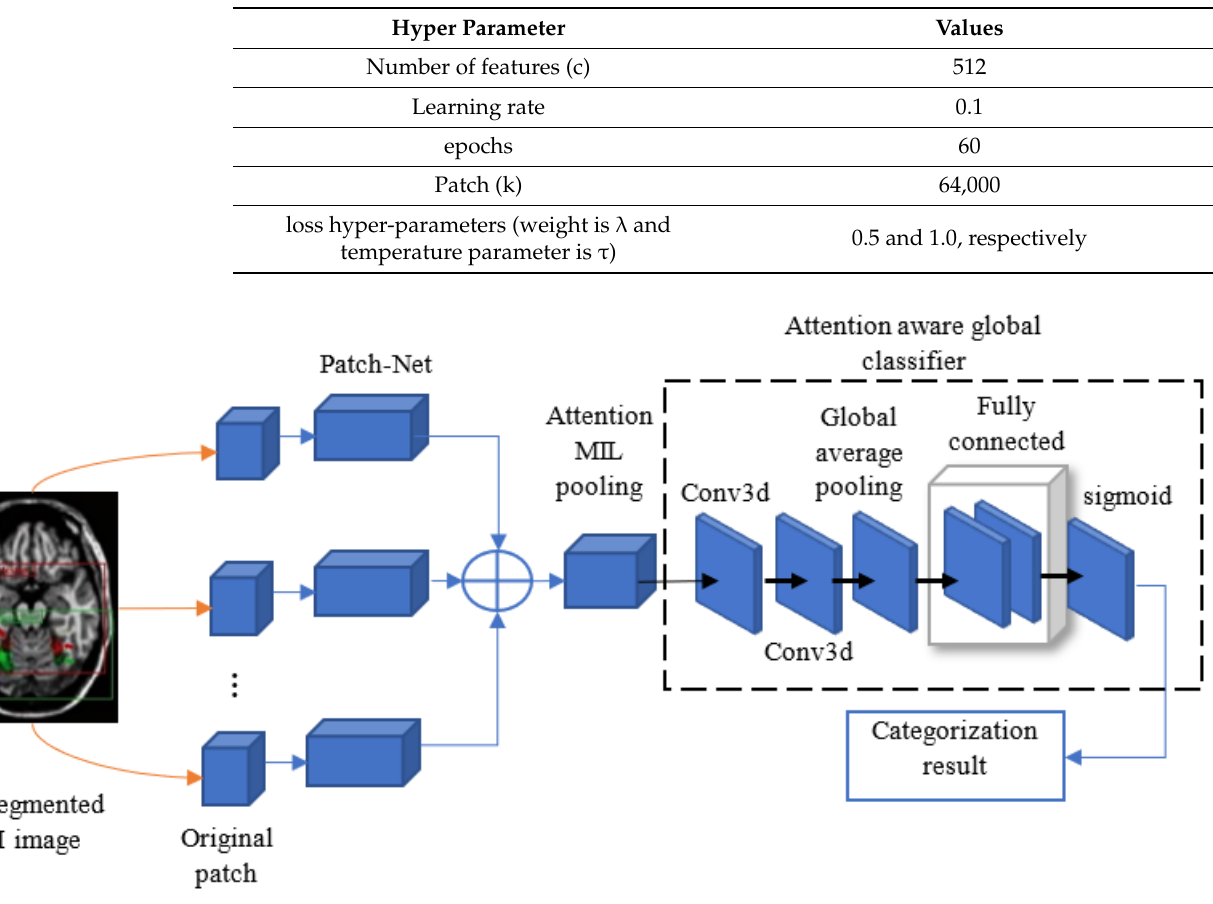
Figure 3. Illustration of the DA-MIDL [20]. Reprinted with permission from ref. [20]. Copyright 2021 IEEE.